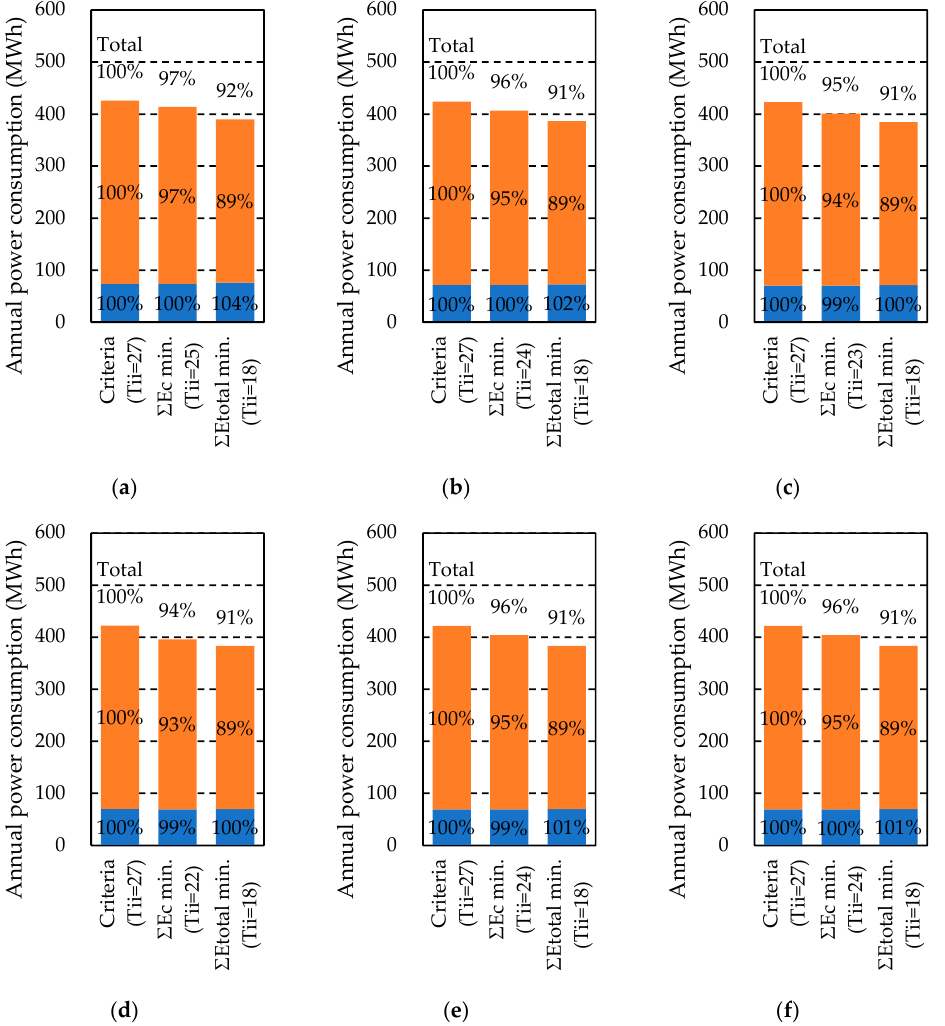
Figure 23. Annual power consumption within the recommended environmental range stated in the American Society of Heating, Refrigerating and Air-Conditioning Engineers (ASHRAE) thermal guidelines: ( a ) ASE = 0.5, ( b ) 0.6, ( c ) 0.7, ( d ) 0.8, ( e ) 0.9, and ( f ) 1.0. Energies 2020 , 13 , x FOR PEER REVIEW